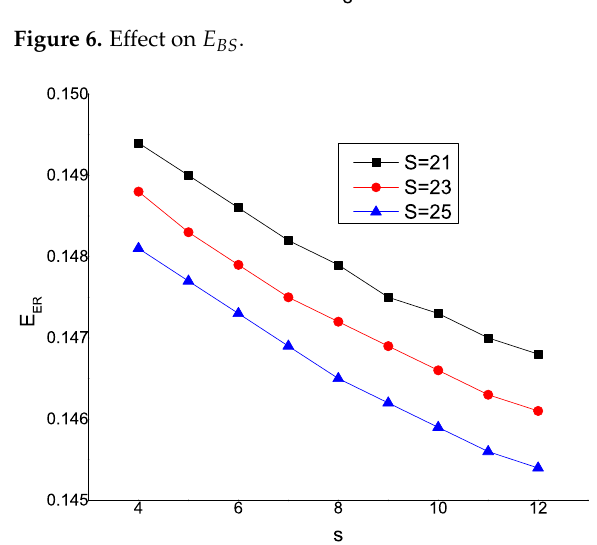
Figure 6. Effect on E BS .